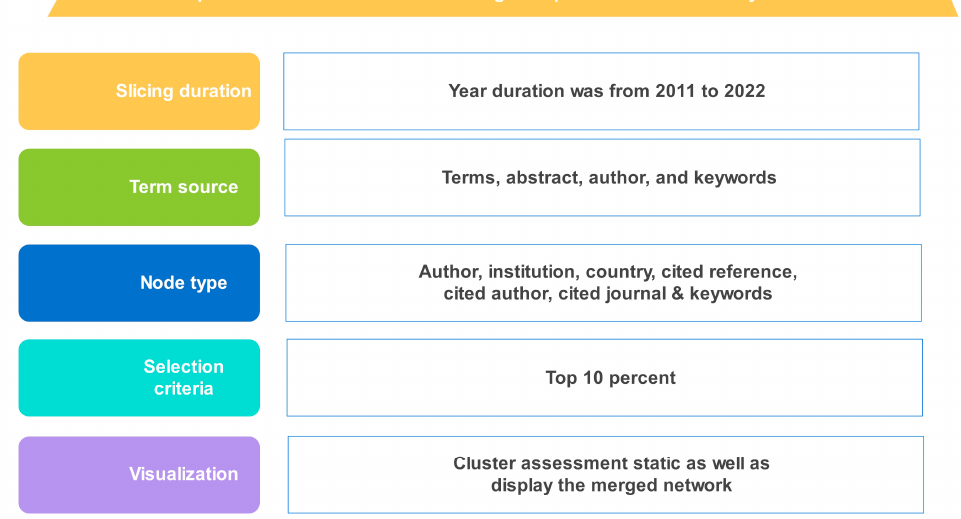
Figure 1. Parameters taken for the big data pandemic control research in CS.